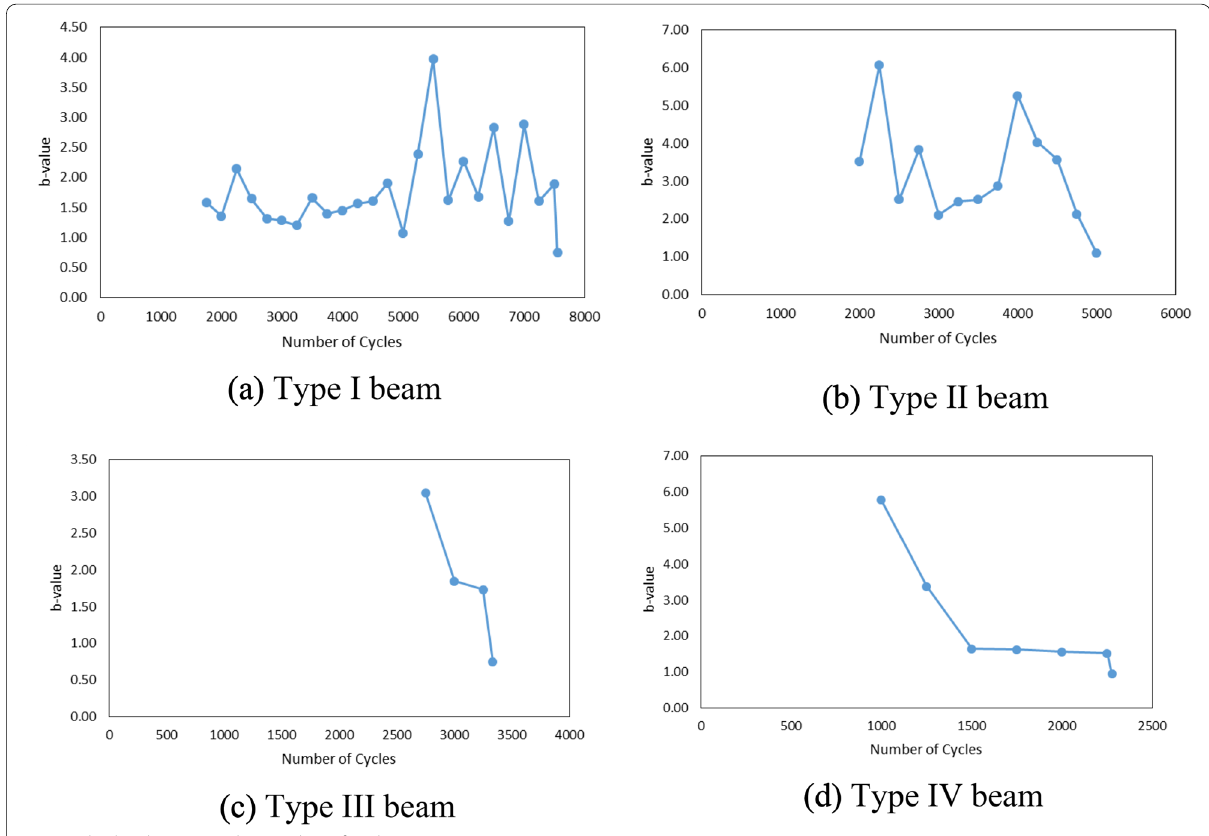
Fig. 7 The b -value versus the number of